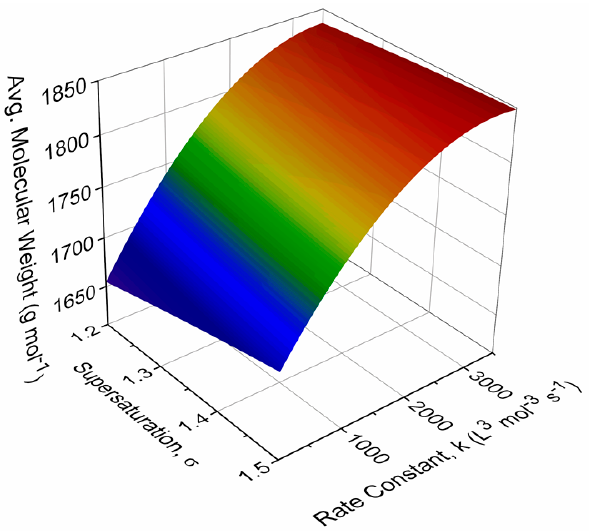
Figure 4. Steady ‐ state distribution of the average molecular weight of SBU oligomers as a function of initial supersaturation ratio and oligomerization rate constant.